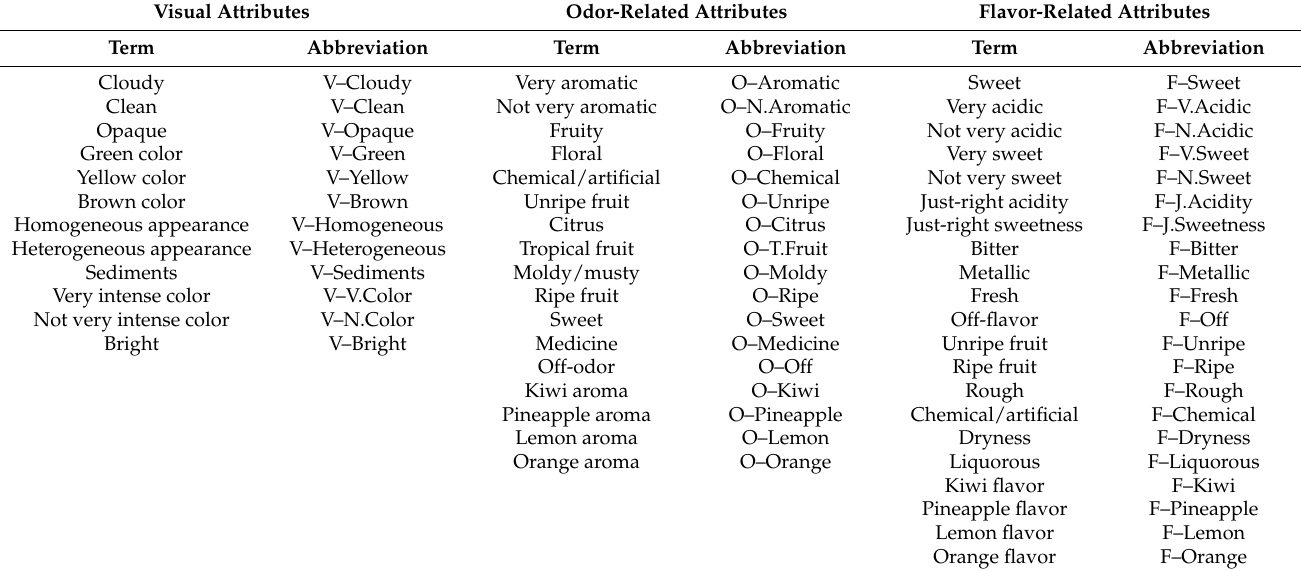
Table 2. Visual, olfactory, and gustatory attributes included in the CATA questions and their abbreviations. Visual